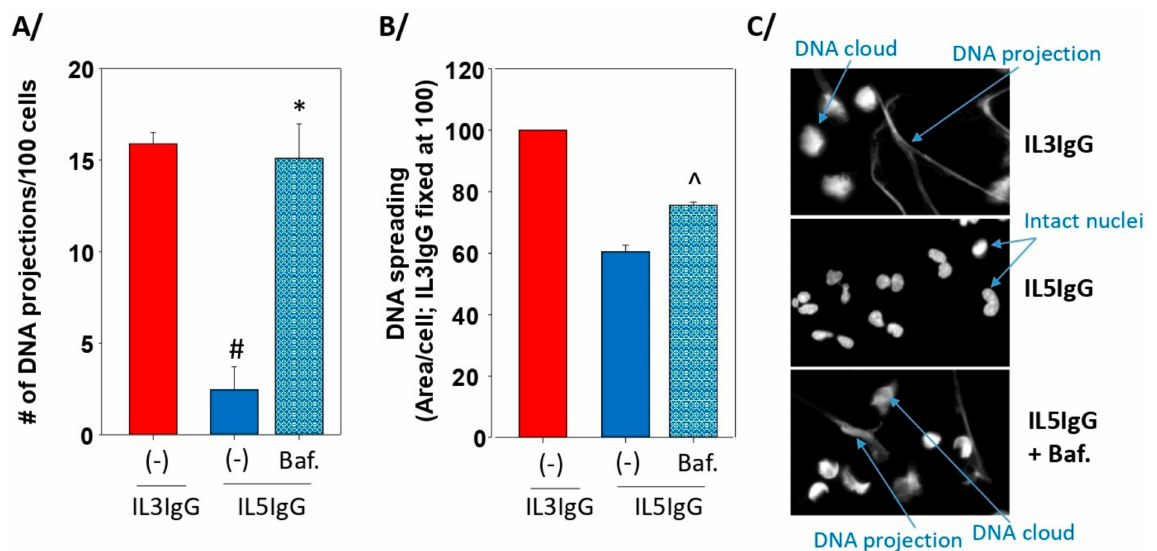
Figure 6. Inhibition of the formation of autophagolysosomes in IL5-primed eosinophils on IgG leads to increased DNA projections and spreading. Eosinophils were primed with IL3 (2 ng/mL) or IL5 (2 ng/mL) for 20 h and were seeded on coated HA-IgG for 4.5 h. For IL5 priming, cells were treated with bafilomycin-A1 (Baf.; 1 µ M) or DMSO ((-); vehicle only) for 20 min before seeding on IgG. Cells were fixed and stained with DAPI to visualize DNA. Three experiments using three different blood donors were performed. For each experiment, three to four fields per well were imaged for a total of about 450 cells using a 20 × objective. ( A ) The number of DNA projections was counted and reported per 100 cells. One-way ANOVA followed by Holm-Sidak method: * p < 0.001 between IL5IgG and Baf.IL5IgG; # p < 0.001 between (-)IL3IgG and (-)IL5IgG. ( B ) The surface covered by DNA was measured by ImageJ and reported as area of DNA per cell. IL3IgG was fixed at 100. Student’s t test between IL5IgG and Baf.IL5IgG: ˆ p < 0.0014. ( C ) A representative image of the three conditions is